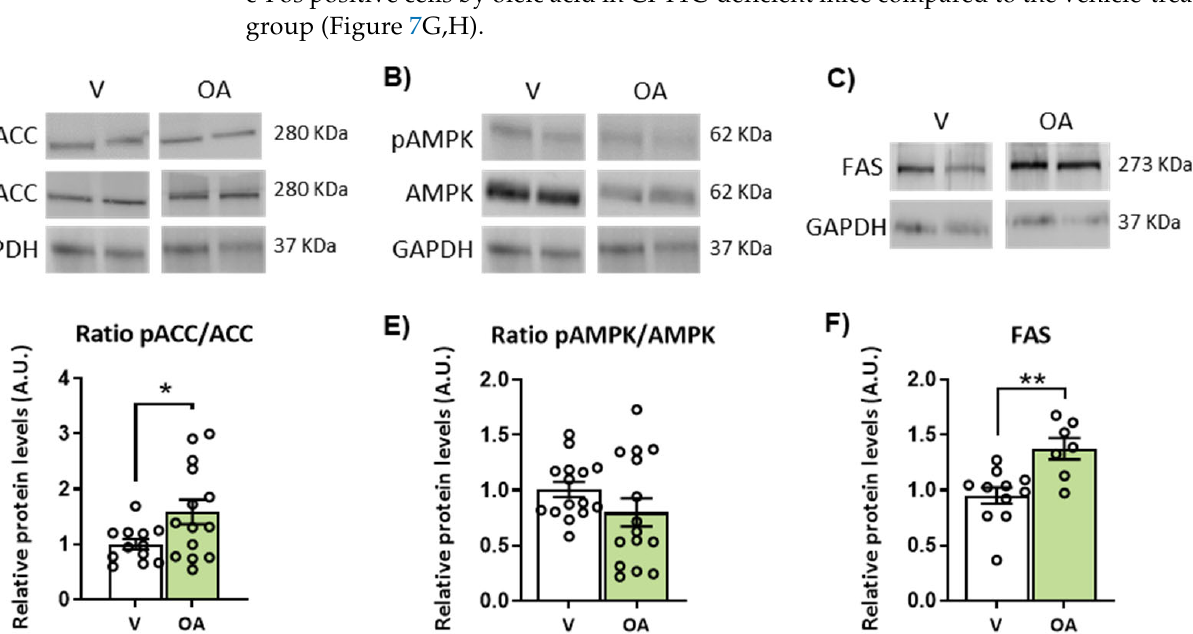
Figure 7. Effects of intracerebroventricular (ICV) administration of oleic acid on the expression of ACC, AMPK and FAS and neuronal activation in the hypothalamus of CPT1C ‐ KO mice. ( A – C ) Rep ‐ resentative blots of pACC, ACC, pAMPK, AMPK and FAS and ( D ‐ F ) quantification of the pACC/ACC and pAMPK/AMPK ratios and FAS protein levels in the hypothalamus of mice after 48 h of ICV administration of oleic acid. ( G ) Representative images and ( H ) quantification of immuno ‐ histochemistry for c ‐ Fos expression (c ‐ Fos positive cells) in paraventricular (PaV), ventromedial (VMH) and arcuate (ARC) nucleus of the hypothalamus after 48 h of ICV administration of oleic acid. Data are represented as mean ± SEM (panels D – F : 2 blots from 8 different mice per group; panel H: n = 3 per group, 2–3 slices/mice). * p < 0.05, ** p < 0.01 vs. its corresponding vehicle. FAS: Fatty acid synthase. OA: oleic acid; V: vehicle. 3V: third ventricle. Scale bar = 250 μ m. 3. Discussion Sensing and metabolism of lipids in the hypothalamus is a key signal of nutrient sta ‐ tus to modulate energy balance, and its disruption leads to obesity and associated com ‐ plications. In the hypothalamus, LCFA promote different types of intracellular signaling to regulate glucose homeostasis, appetite and energy expenditure. To date, the effects of saturated or unsaturated LCFA on the hypothalamus–BAT thermogenesis axis and the exact mechanisms underpinning these actions have remained largely unclear. The present research demonstrates that the presence of LCFA in the brain with different levels of sat ‐ uration impacts differently on the regulation of appetite and BAT thermogenesis. We found notable BAT thermogenesis activation induced by a MUFA ‐ enriched diet and cen ‐ tral injection of unsaturated LCFA (oleic and linoleic acid), whereas this activation was